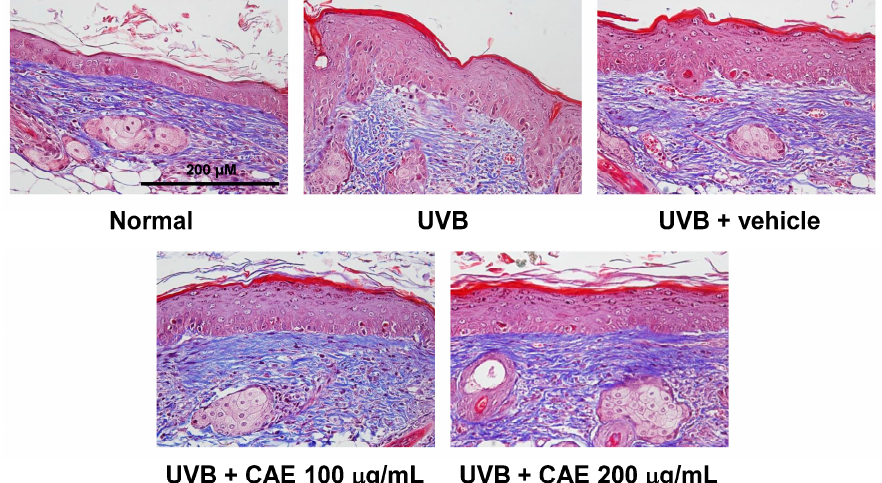
Figure 16. Light micrographs of histological sections of hairless mice stained with Masson’s trichrome. Collagen fibers were stained blue. UVB exposure reduced the collagen content in the mouse skin dermis and CAE treatment restored the collagen content.